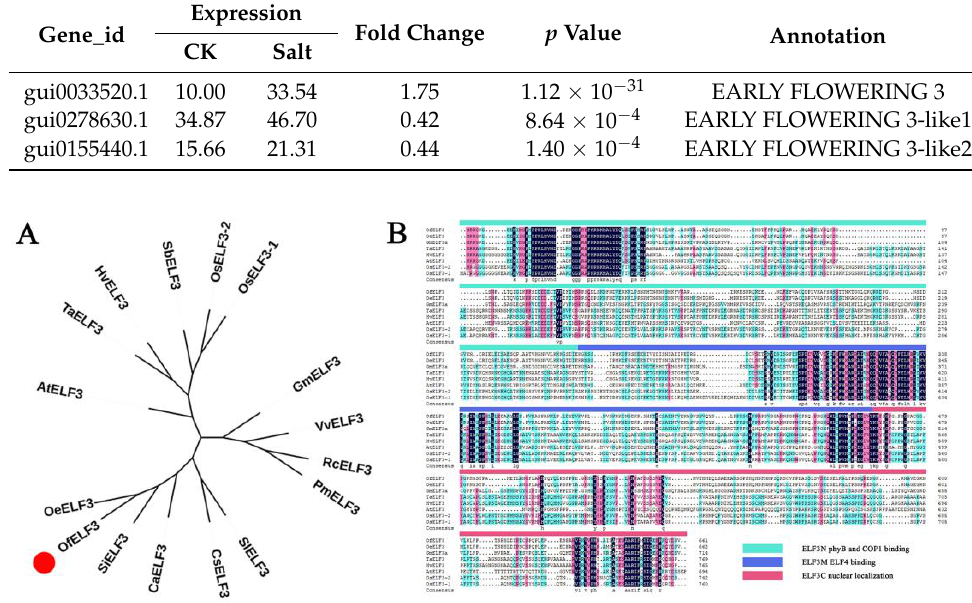
Figure 1. Phylogenetic tree and sequence analysis. ( A ) Phylogenetic tree analysis of ELF3 with other